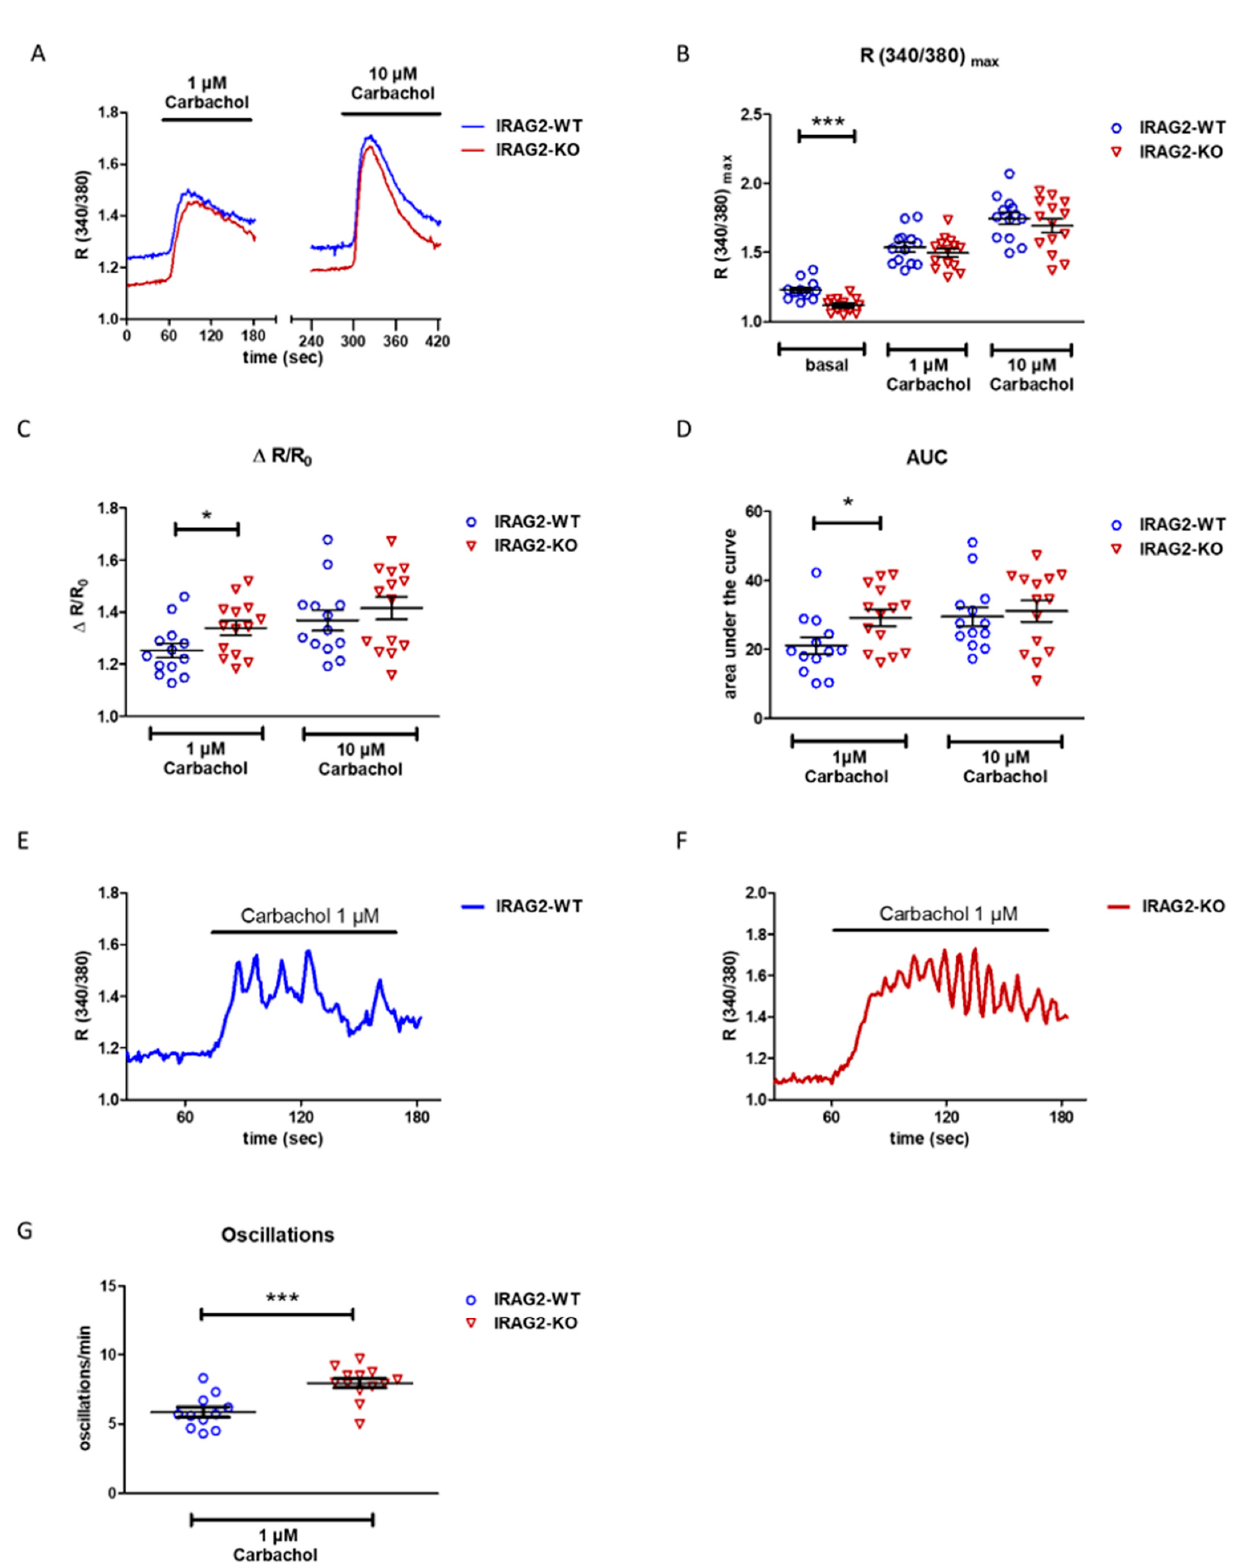
Figure 3. Regulation of intracellular calcium in isolated pancreatic acinar cells from IRAG2-WT and IRAG2-KO mice. ( A ) Stimulation of calcium release in Fura-2-AM loaded cells (2 µ M Fura-2-AM; 90 min in the dark at room temperature (RT)) with 1 µ M carbachol and 10 µ M carbachol. Cells were stimulated with different carbachol concentrations for 2